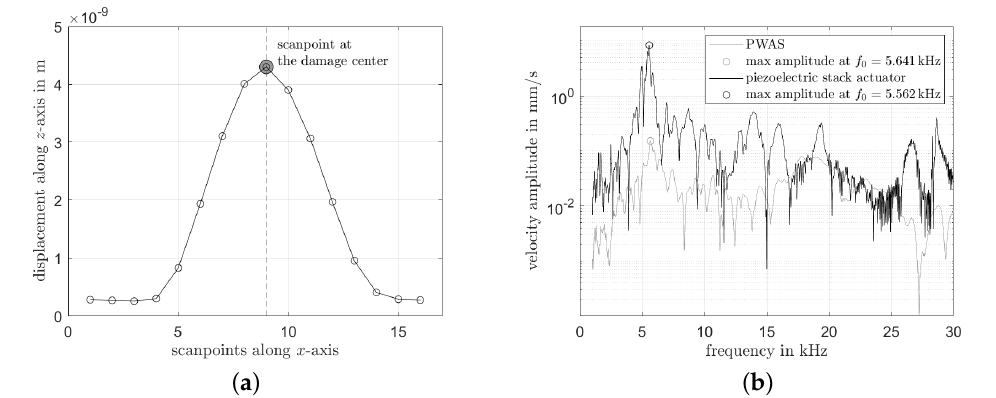
Figure 5. Illustration of dynamic responses of the debonded area to a broadband excitation via the piezoelectric wafer active sensors (PWAS) by the scanning laser Doppler vibrometer (SLDV) results. ( a ) Eigenmode of debonded face layer at the first damage resonance frequency f 0 . ( b ) Velocity amplitude of dynamic response at the SLDV scan point at the center of the debonding for both